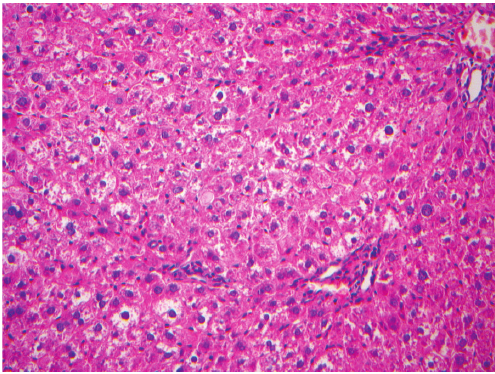
Figure 4: The pathological stage of the 9th–12th week is S3.